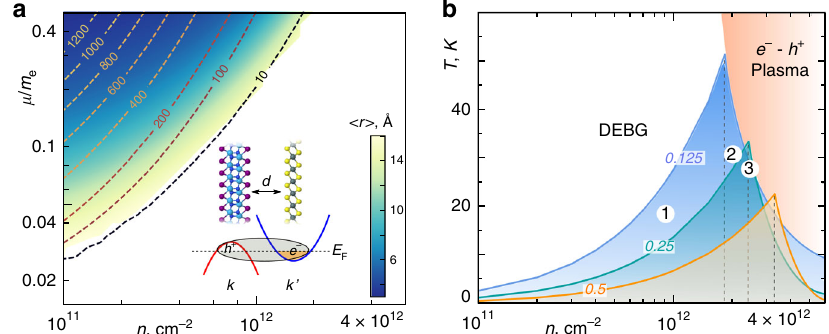
Fig. 2 Model of exciton condensation in 2D bilayer heterostructure. a Binding energies (lines labeled by meV) and exciton radius (color map) in a metallic bilayer with interlayer separation d = 3 Å as a function of reduced effective mass μ and carrier density n . Highlighted area shows the region with bound states. b Phase diagram for excitons in bilayer semimetal. BKT line for transition to quasi-condensate and BCS line for different reduced mass (0.125, 0.25, and 0.5) are shown (equal carrier masses are assumed). Outside of the condensate region, a degenerate exciton Bose gas (DEBG) exists on the low density side, and electron-hole plasma on the high density side. The estimated critical temperatures ( T c ) for materials labeled (1, 2, and 3) in Fig. 3 are also